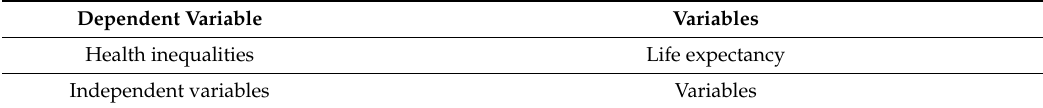
Table 1. Description of